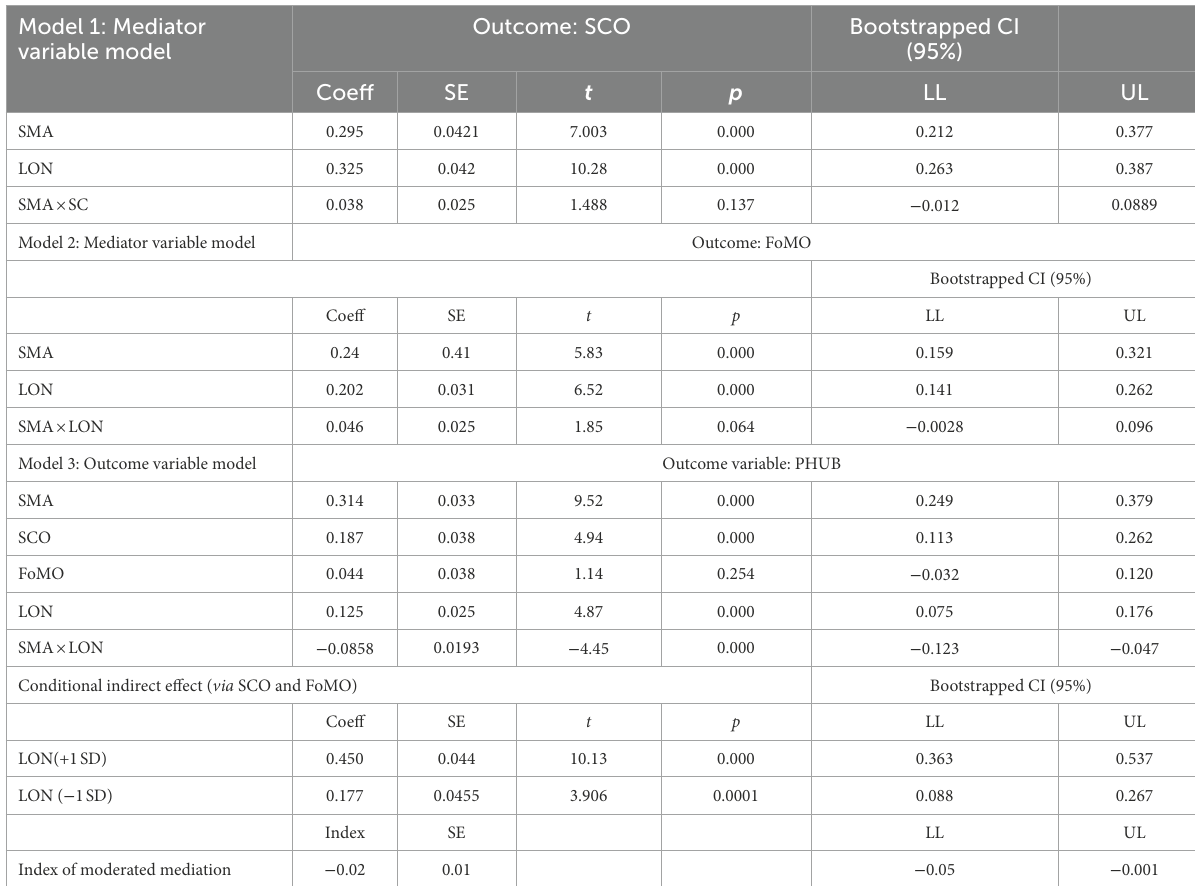
TABLE 4 Moderated mediation analyses’ results (PROCESS: model 8). Model 1: Mediator variable model